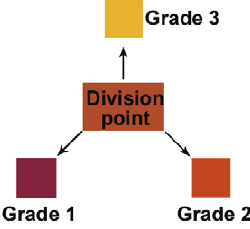
Figure 6. Differences between the color at the division point and the colors of the mathematical expectation points for each grade.